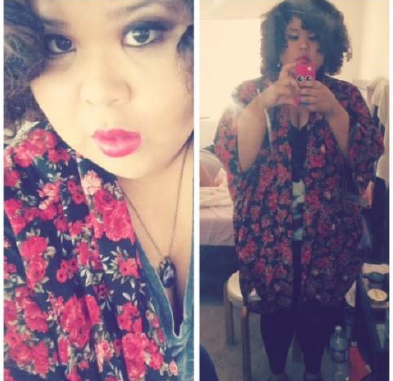
Figure 1. Image description: split photo. One close up and one full body photo. Person wears a floral chiffon robe, dark top and black leggings, red lipstick. In the picture you see me, a half African American and half Navajo. I look like an art teacher…But I’m not xD. Welcome to the story of my life~ (reproduction permission granted).